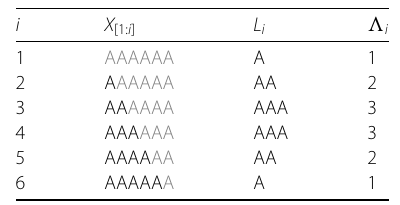
Table 2 An example illustrating the innerworkings of Equation 1 on an example input sequence X = ( A , A , A , A , A , A ). The notation X [1: i ] denotes the symbols in X from 1 to i – 1, L i denotes the shortest subsequences that starts at position i and does not appear from 1 to i – 1 in the original sequence, and (cid:2) i is given by | L i